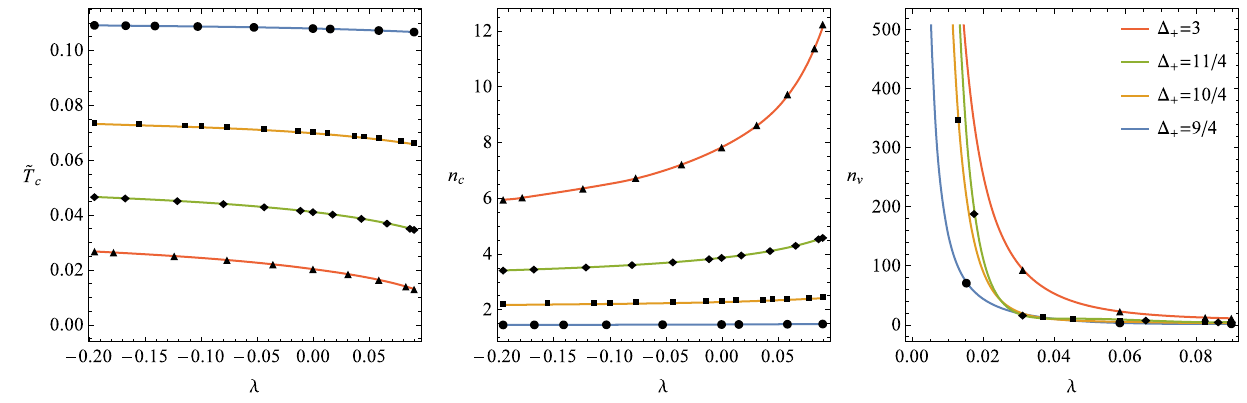
Fig. 12 From left to right, the critical temperature, the critical Rényi parameter, and the violation number in terms of the GB